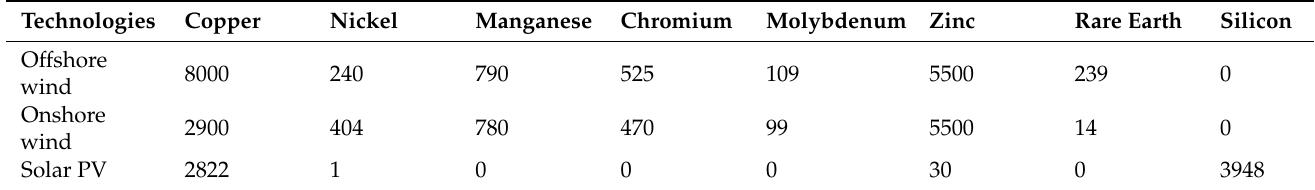
Table 8. Clean energy generation technology mineral resource consumption (Unit: t/GW) (Data Source: